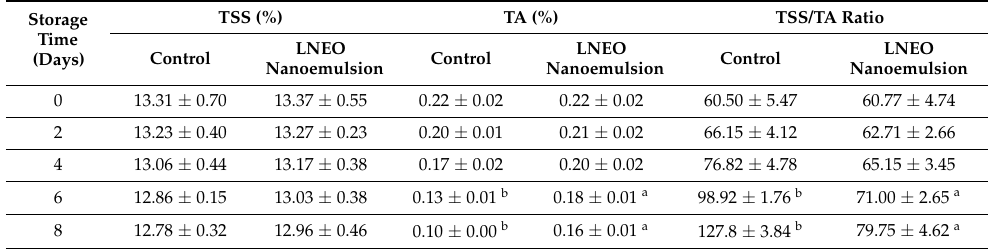
Table 2. Effects of the LNEO nanoemulsion on TSS and TA content in fresh-cut muskmelons. Storage